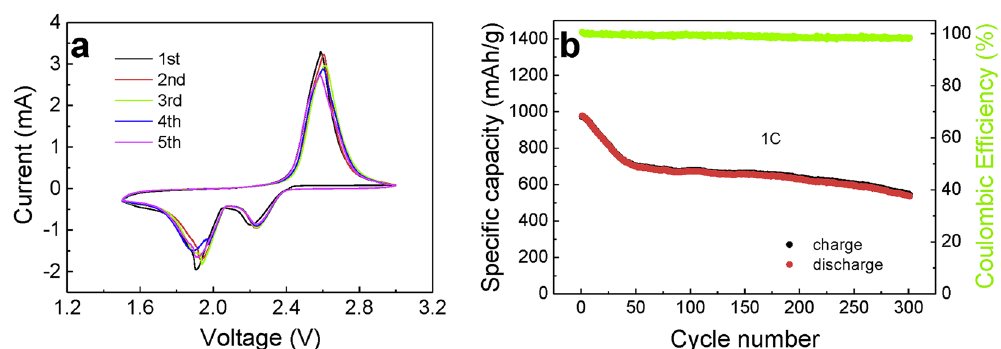
Figure 3. ( a ) Cyclic voltammograms of the MWCNTs/S/PPy composite electrode in the voltage range of 1.5~3 V vs. Li + /Li, recorded at a potential scanning rate of 0.5 mV. ( b ) Cycling performance of the MWCNTs/S/ PPy composite at a current density of 1